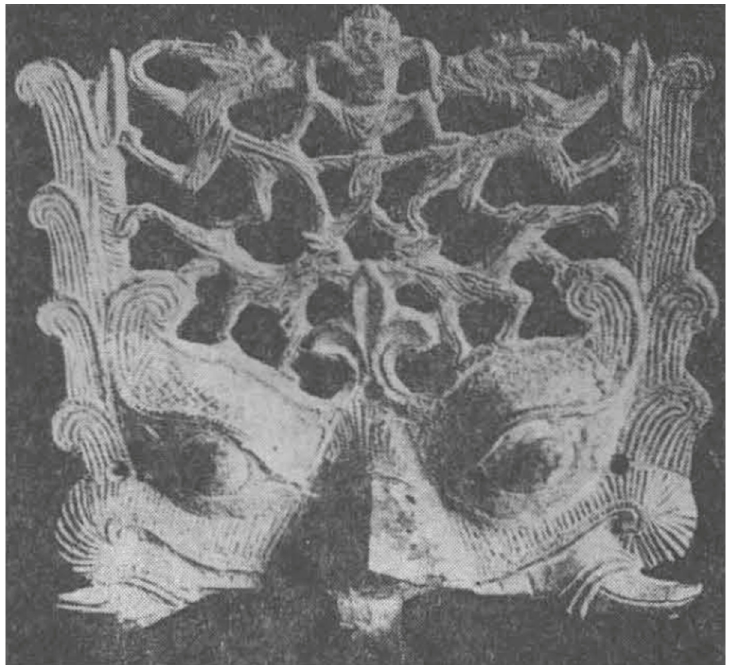
Figure 14. Pushou with human–animal juxtaposition, gilt bronze, Collection of Kyoto University; after (Hayashi 1985, Figure 38).